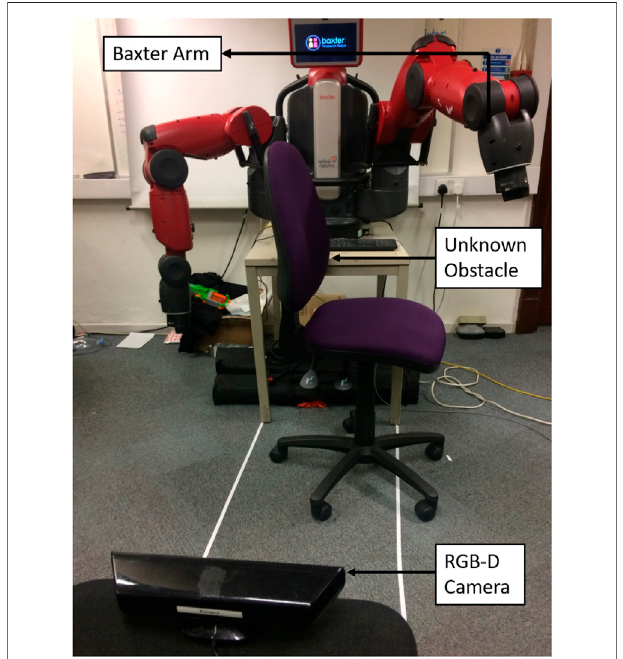
FIGURE10| The fi guredepictsexperimentalsetupconsistingofaseven DOFs Baxter manipulator. The environment consists of a chair detected by RGB-D camera.